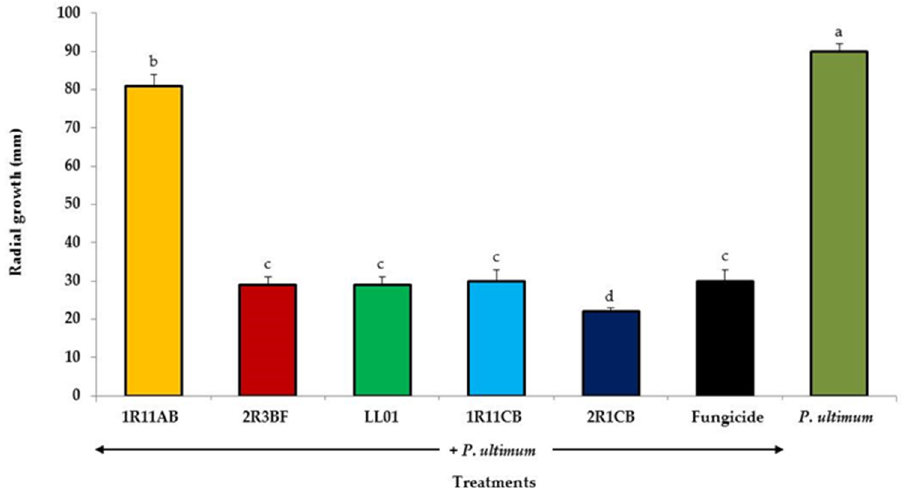
Figure 2. Effect of marine yeasts on the radial growth of Pythium ultimum . The yeasts are Debaryomyces hansenii (1R11AB, 1R11CB, and LL01) and Cryptococcus laurentii (2R3BF and 2R1CB). Data are shown as the mean ± standard deviation (SD) ( n = 100). Columns with different letters were significantly different according to Tukey’s test ( p < 0.05).